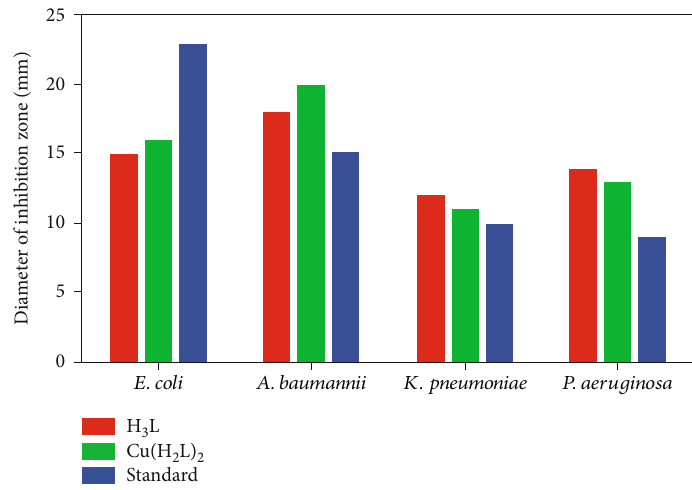
Figure 12: Inhibition zone of H